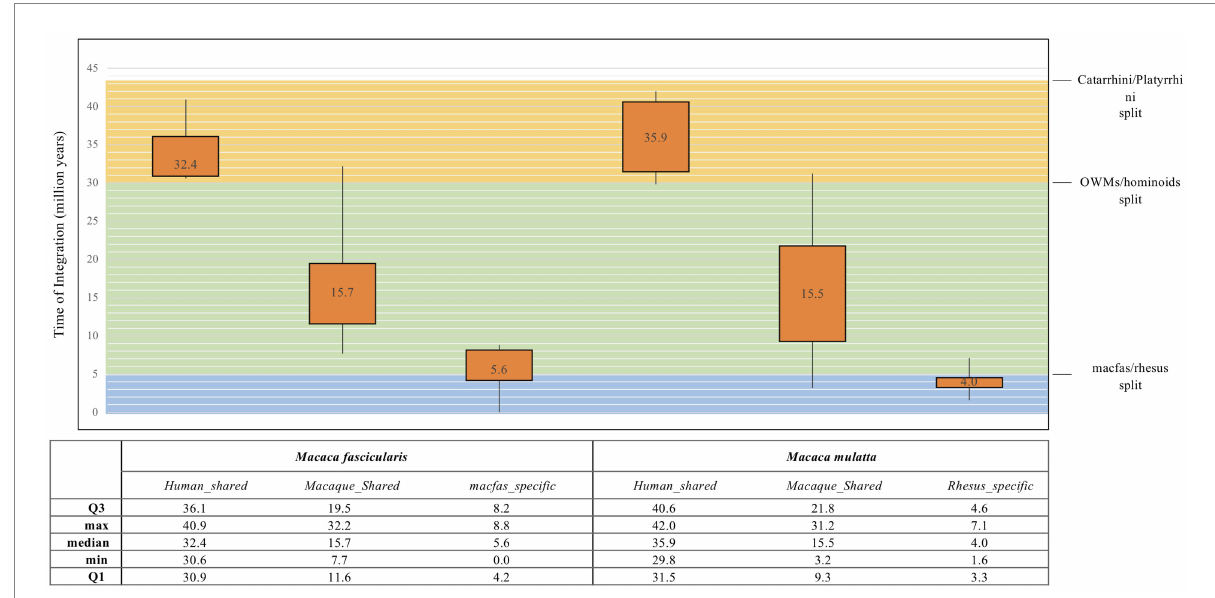
FIGURE 3 Box plot representation of HML2 diffusion in macaques. The age for all the three categories of macaque HML2 sequences (human shared, macaque shared, and species specific) were calculated by considering divergence between the (i) 5 ′ and 3 ′ LTR of same HML2 loci; (ii) LTR vs. Consensus generated; (iii) gag and pol genes against the consensus of each gene. The values in the box plot are the mean values. The theoretical age ranges for the three categories based on evolutionary divergence times are indicated with colored boxes for Catarrhini/Platyrrhini (around 43 mya, orange), OWMs/hominoids (around 30 mya, green), and macfas/rhesus (around 5 mya,